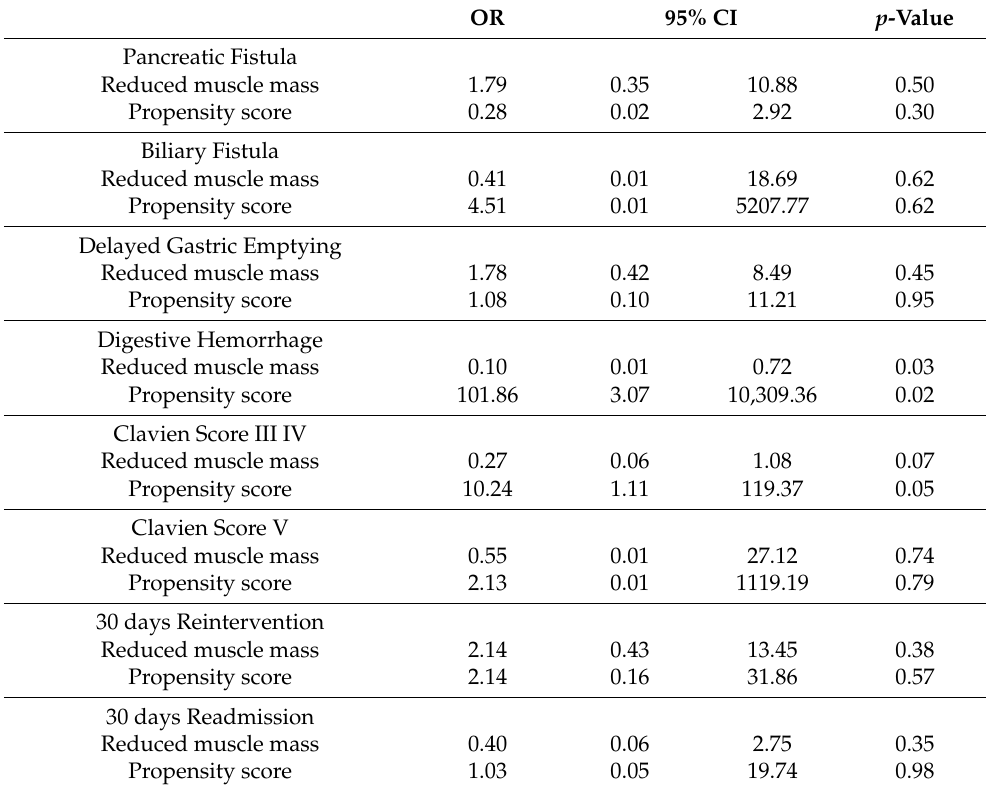
Table 4. Multivariable analysis with propensity scores for the risk of adverse clinical